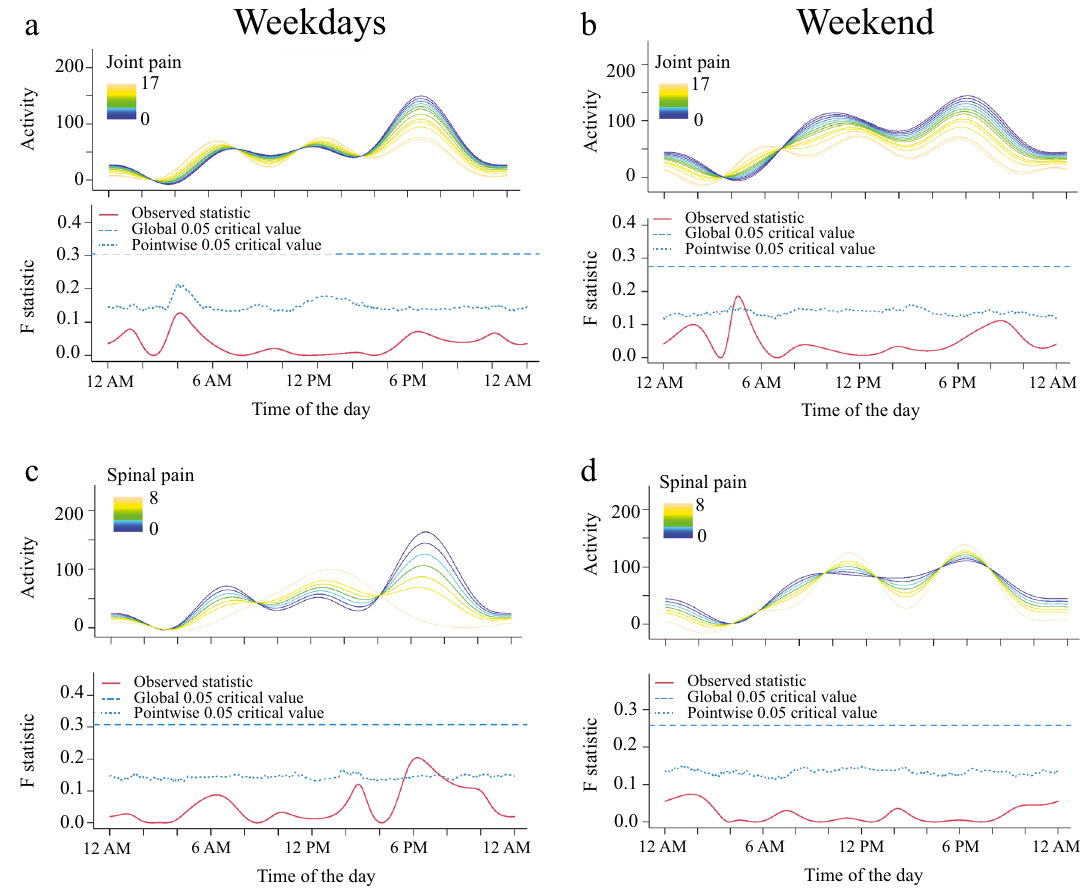
Figure 4. Relationship between joint ( a,b ) and spinal pain ( c,d ) on activity levels in senior dogs. The upper graph illustrates activity over time for different levels of the variables analyzed and the lower graph indicates the level of significance of the differences. When the observed statistic (red line) is above the test of significance set at 0.05 (blue lines) it indicates significant differences between different levels of the variable. The dashed and the dotted lines indicate global and point-wise test of significance respectively. Dogs with greater joint pain were more active between 4.15 and 5 AM during the weekend ( b ) but not during weekdays ( a ). Dogs with higher spinal pain were less active in the evening between 5.30 and 7.15 PM during weekdays ( c ) but not during the weekend ( d